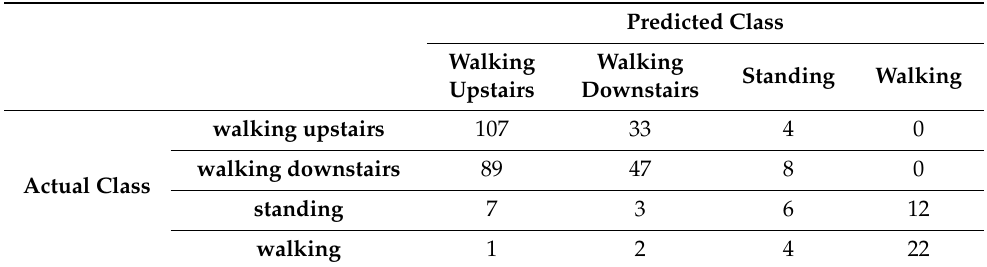
Table 4. Confusion matrix for normalized gyroscope data with